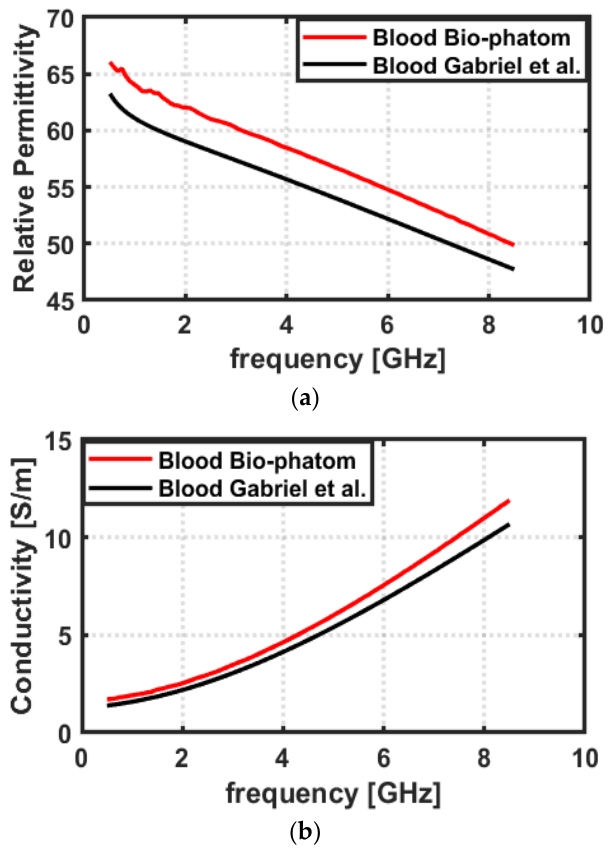
Figure 10. Dielectric properties of blood bio-phantom over 0.5–8.5 GHz frequency band: ( a ) Relative permittivity, ( b ) conductivity. The measured dielectric data of bio-phantom(red curve) is compared with the reference data (black curve) from Gabriel et al.